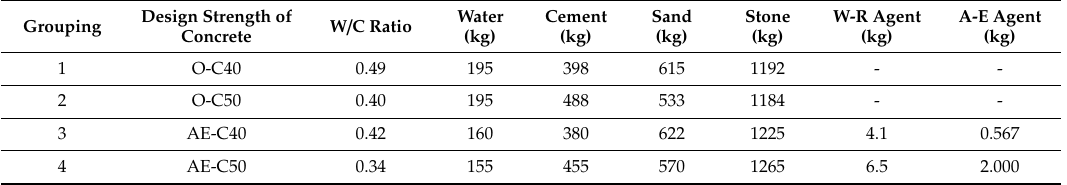
Table 1. Concrete mix proportion (material consumption per cubic